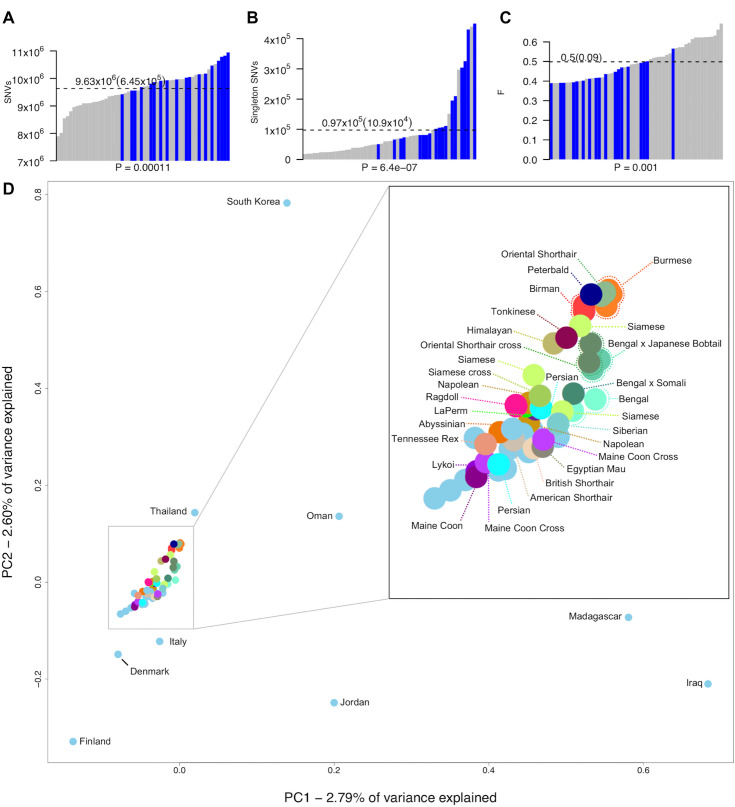
Genetic variation in whole genome sequenced cats.(a) Number of SNVs found in each genome, (b) singletons per genome, and (c) the per sample inbreeding coefficient F. Blue bars indicate each individual random bred cat and grey bars indicate each individual breed cat. P-values underneath each x axes were calculated using Wilcoxon rank-sum test and were used to compare breed cats to random bred cats. Dotted lines indicate the mean for each statistic, which is printed above along with standard deviation in braces. (d) Population structure of all unrelated cats (including Bengal breeds) estimated using principal components analysis. Random bred cats are colored light blue. Those that were sampled globally for diversity regions are named according to their sampling location. All other cats are named according to their breed or breed cross.